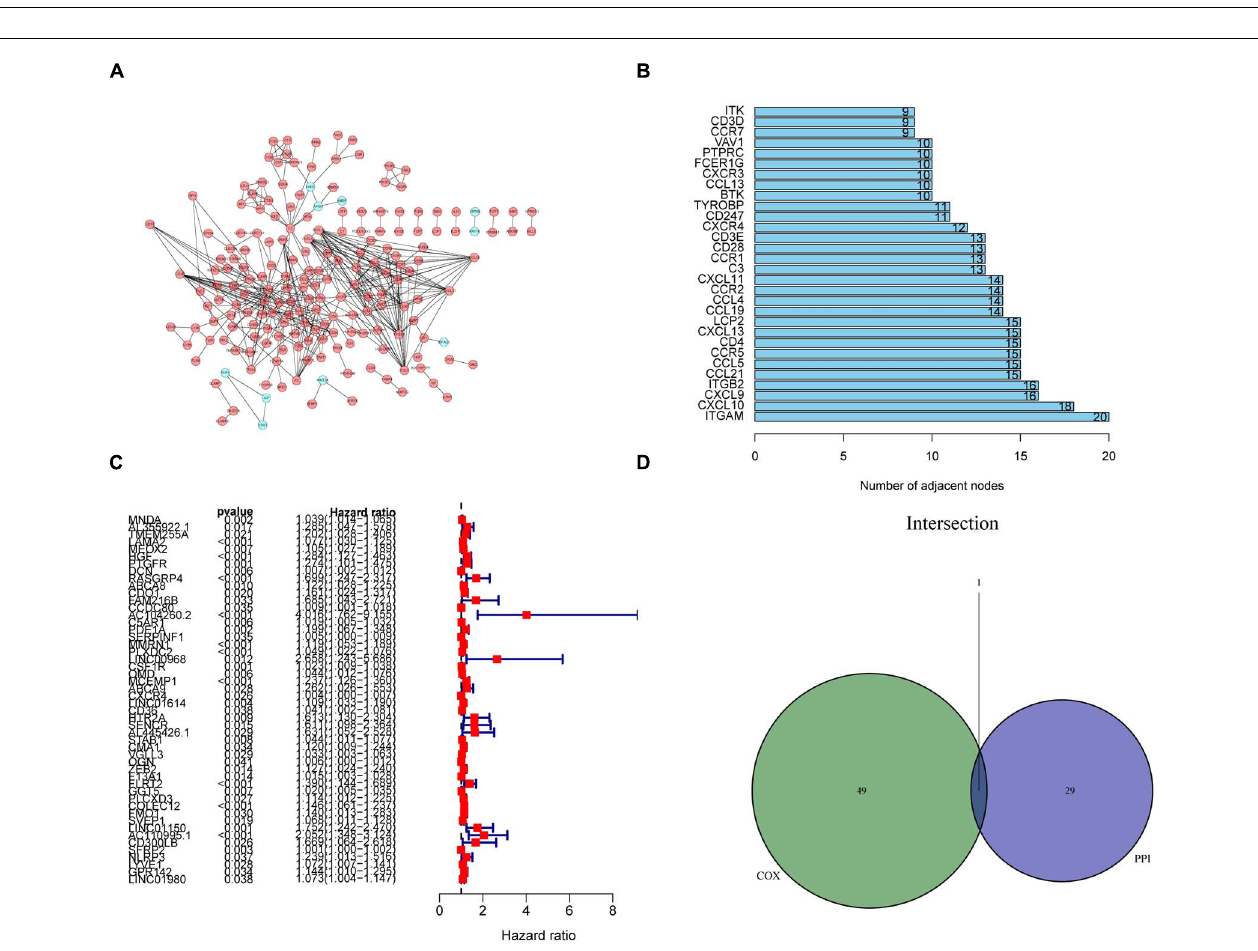
FIGURE 5 | Protein–protein interaction (PPI) network and univariate Cox regression analysis. (A) Construction of the PPI network of 1231 differentially expressed genes (DEGs). (B) The top 30 genes ranked by the number of adjacent nodes of the PPI network. (C) Results of univariate Cox regression analysis with selected DEGs, with the top 50 genes displayed in the forest plot. (D) A Venn diagram showing CXCR4 as the most commonly expressed DEG in gastric cancer by combination analysis of the top 30 genes in the PPI network and the top 50 prognostic genes from the results of Cox regression analysis.